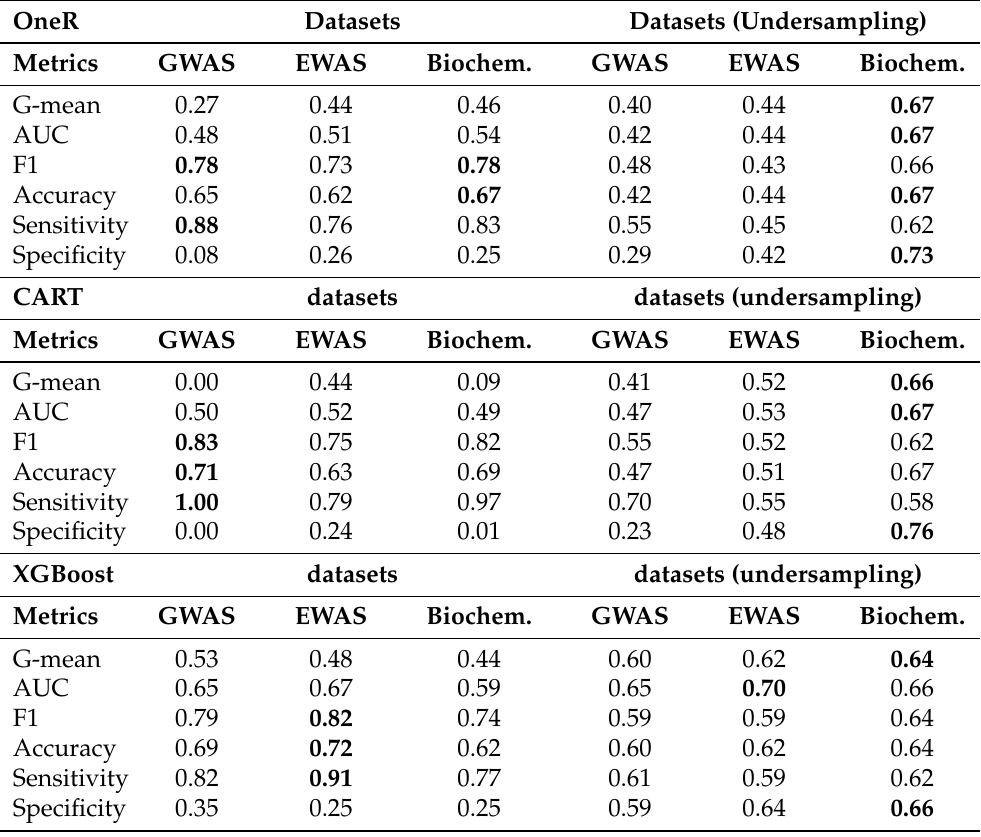
Table 2. Classification metrics obtained using OneR, CART, and XGBoost classifiers with/without undersampling in the different training